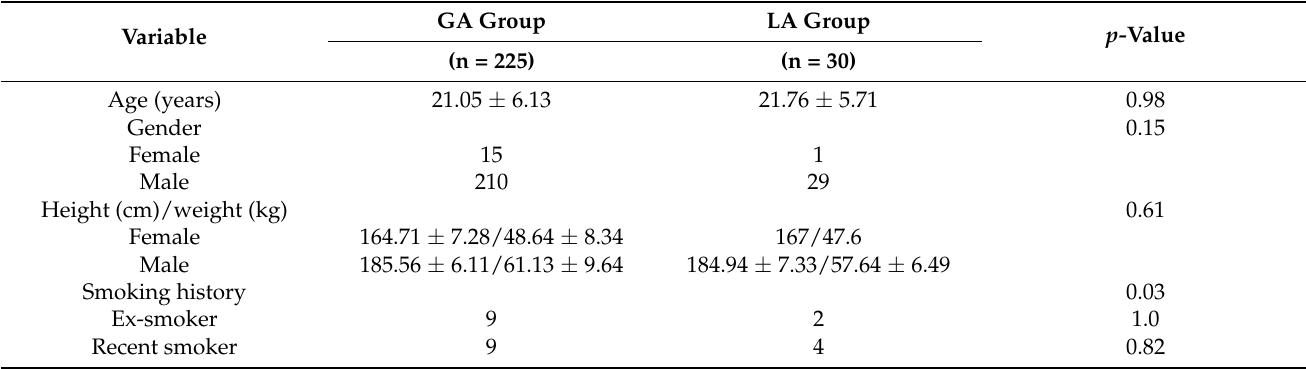
Table 2. Patient demographic characteristics.